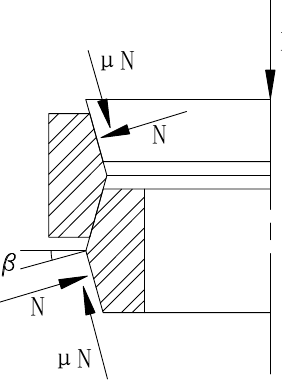
Figure A1. Ring spring force diagram.